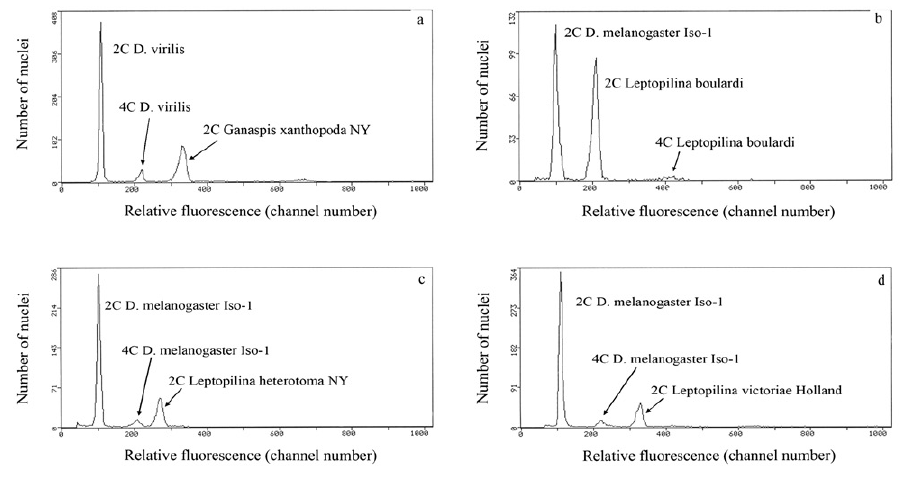
Figure 1. Cytograms showing relative fluorescence and total propidium iodide-stained nuclei of samples and standards to determine genome size. a relative fluorescence of PI-stained 2C nuclei from one head of a Ganaspis xanthopoda strain NY female co-prepared with 2C and 4C nuclei from one head of a Drosophila virilis female standard (1C = 333 Mb) b–d relative fluorescence and total PI stained nuclei of co-prepared Leptopilina and D. melanogaster (1C = 175 Mb) to determine genome size for L. boulardi (panel b), L. heterotoma (panel c), and L. victoriae (panel d). Genome size is calculated as follows: (mean fluorescence channel number of sample 2C peak/mean fluorescence channel number of 2C standard peak) X 1C DNA content of the standard, with the genome size mean and standard error calculated from repeat co- preparations using different individuals of each